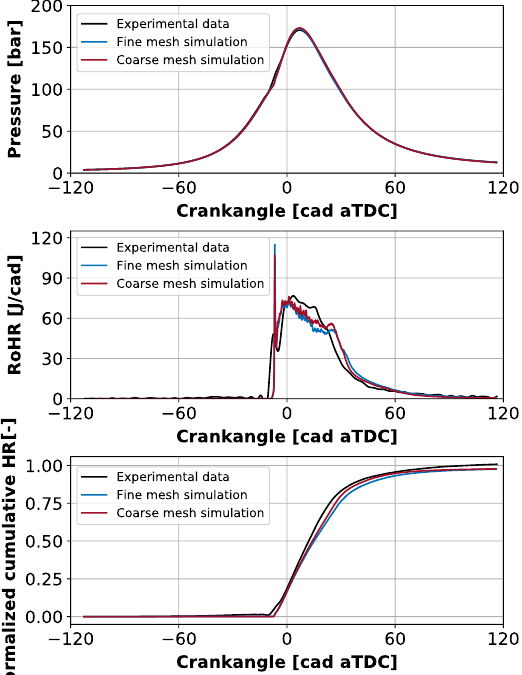
Figure 2. Comparison between experimental data, fine-mesh, and coarse-mesh simulation results of in-cylinder pressure ( top ), RoHR ( middle ), and normalized cumulative HR ( bottom